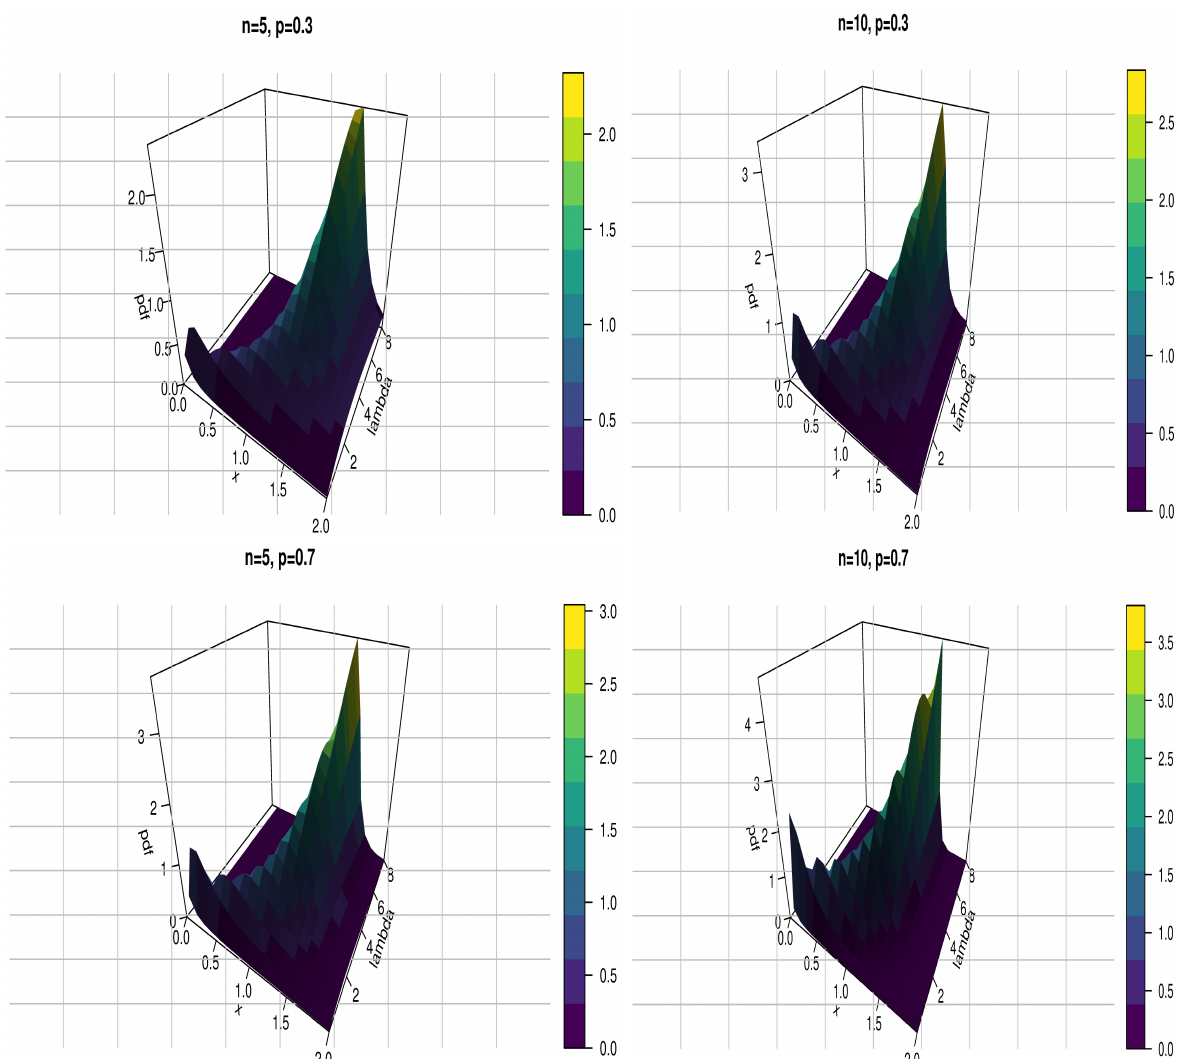
Figure 5. Three-dimensional different shapes of pdf for FB distribution at β =